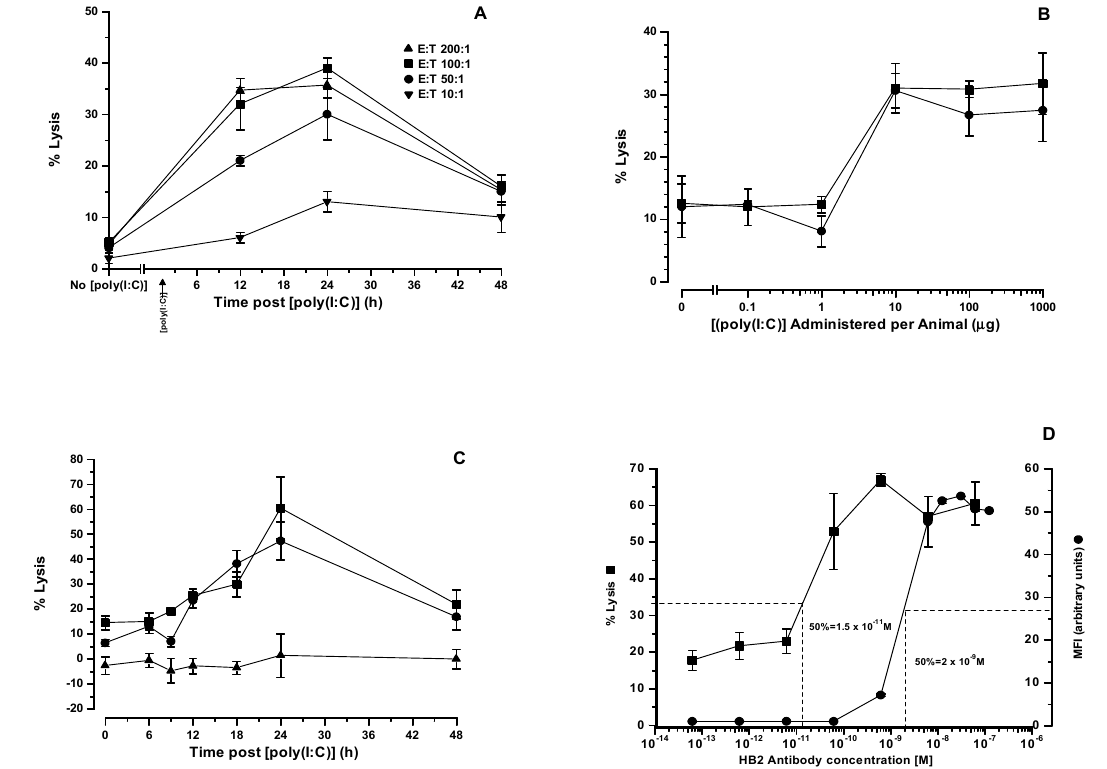
Figure 1. Lytic characteristics of effector splenocytes taken from SCID mice stimulated with [poly (I:C)]. ( A ) Percentage lysis of YAC-1 target cells following incubation with effector splenocytes taken from SCID mice at 12, 24, and 48 h after i.v. injection of 10 μ g of [poly (I:C)] at E:T (effector:target cell) ratios of 10:1, 25:1, 50:1, and 100:1 ( B ) Percentage lysis of HB2 antibody coated HSB-2 cells (treated at HB2 antibody concentration of 6.25 × 10 − 11 M ● and 6.25 × 10 − 10 M ■ ) following incubation with splenocytes from SCID mice injected i.v. 24 h previously with [poly (I:C)] at 0, 0.1, 1, 10, 100, and 1000 μ g/animal at an E:T ratio of 100:1 ( C ) Percentage lysis of HSB-2 cells treated with HB2 antibody concentrations of 6.25 × 10 − 11 M ● , 6.25 × 10 − 10 M ■ , and an off-target anti-CD19 control antibody, BU12, at 6.25 × 10 − 10 M ▲ following incubation with splenocytes taken from SCID mice at various times following i.v. injection with 100 μ g [poly (I:C)]. ( D ) Lytic characteristics of SCID splenocytes at a 1:100 E:T ratio for HSB-2 cells in the presence of various concentrations of HB2 antibody ■ plotted alongside the mean fluorescence intensity (MFI in arbitrary units) seen over the same antibody concentration range.